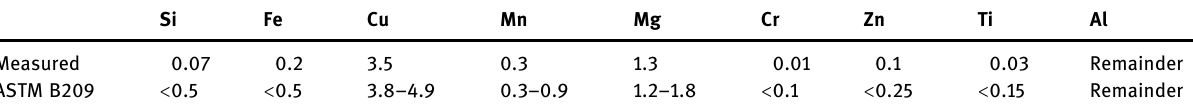
Table 1: Chemical composition of aluminum alloy AA2024 ( wt% )